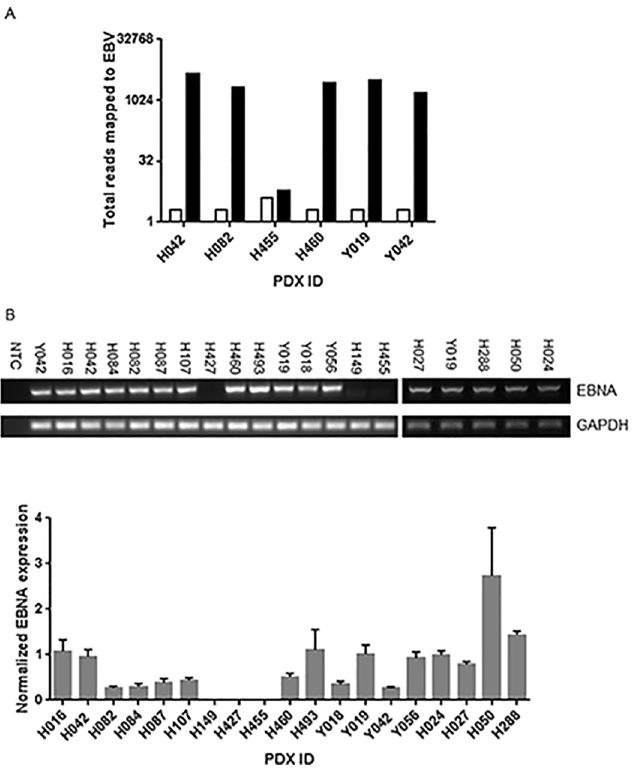
Fig 4. EBV status of PDX lines. A. Total reads, generatedfrom wholegenome exome sequencing, mapped to EBV. Donor Lymphocytes (open bars) were compared to PDX lines (solid bars). B . PCR amplification of EBNA and GAPDH in PDX lines (upper panel). NTC = non template control. Lower panel; normalized EBNA expressionin PDX lines.